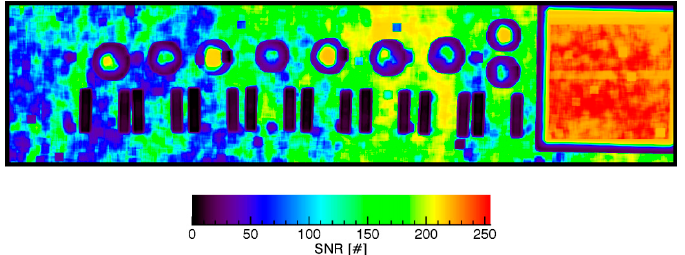
Figure 10. Image SNR variations due to scattering, albedo and illumination gradients.